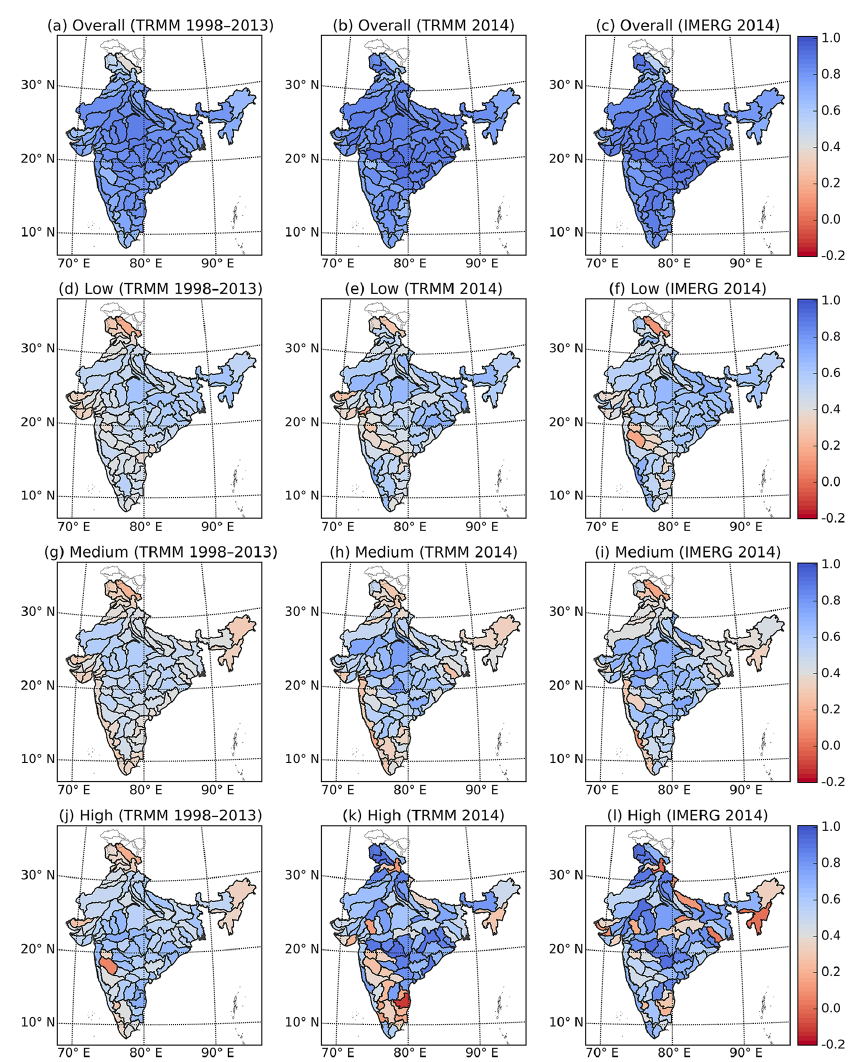
Figure 5. Spatial representation of the correlations of TRMM 1998–2013, TRMM 2014 and IMERG 2014 over 86 delineated river basins across India for (a–c) overall time series, (d–f) low, (g–i) medium and (j–l) high rainfall